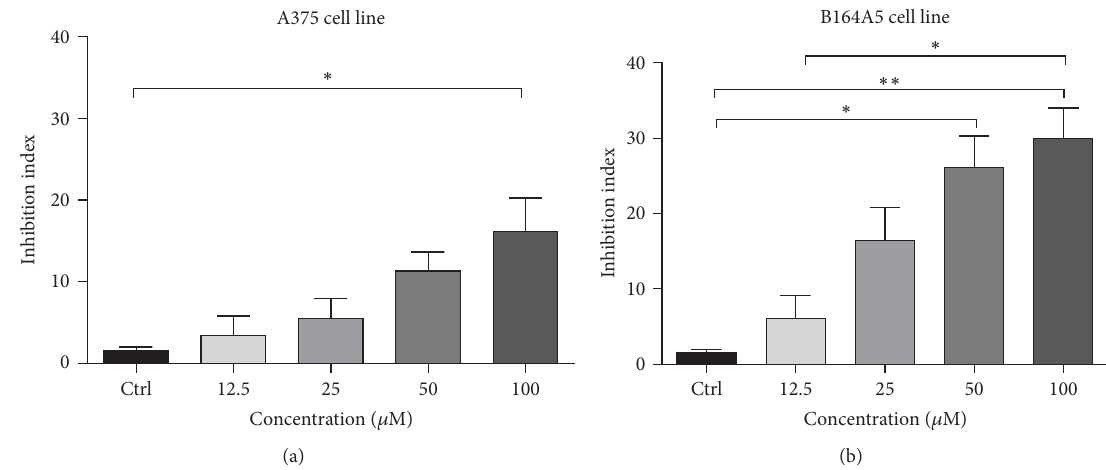
Figure 2: Inhibition index of cells after 72h of incubation with EM2 in (a) A375 human malignant melanoma cell line and (b) B164A5 murine melanoma cell line. Data are presented as means ± SEM. The experiments were carried out in triplicate ( 𝑃 < 0.05 versus Ctrl) . ∗ and ∗∗ indicate 𝑃 < 0.05 and 𝑃 < 0.01 as compared with the control